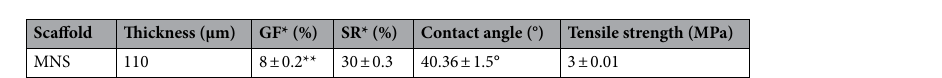
Table 1. Physical properties of the MNS. *The gel fraction (GF %) and the swelling ratio (SR %) of MNS after immersion for a day in deionized water. **The measurements were replicated three times for the same prepared membranes and the standard deviation was evaluated accordingly for all tests.